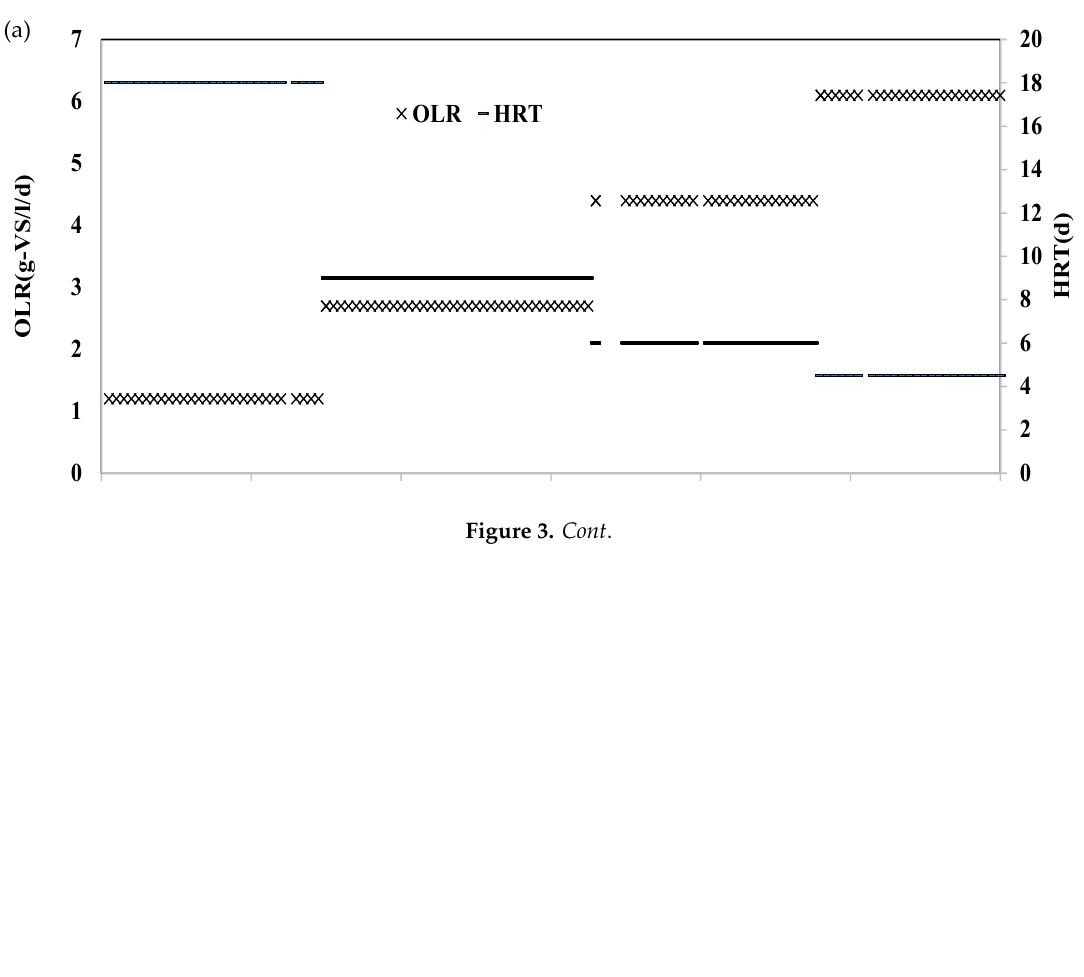
Table 3. The operational performances in H 2 -reactor at various hydraulic retention times (HRT) and organic loading rates (OLR).